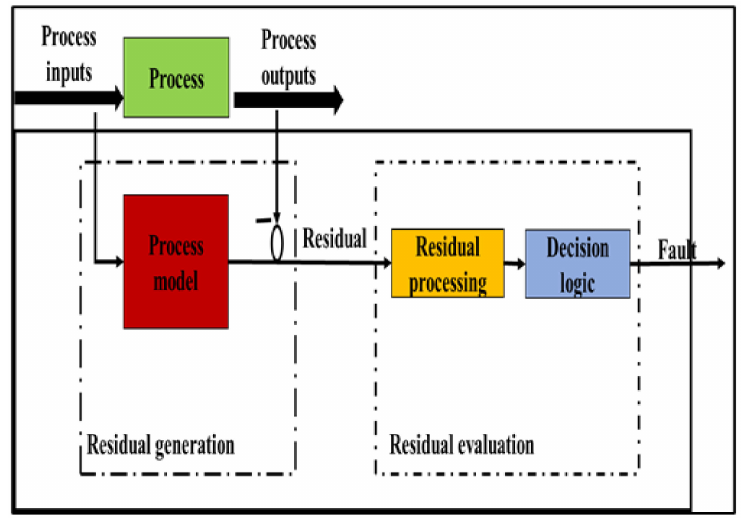
Figure 5. The model-based diagnostic